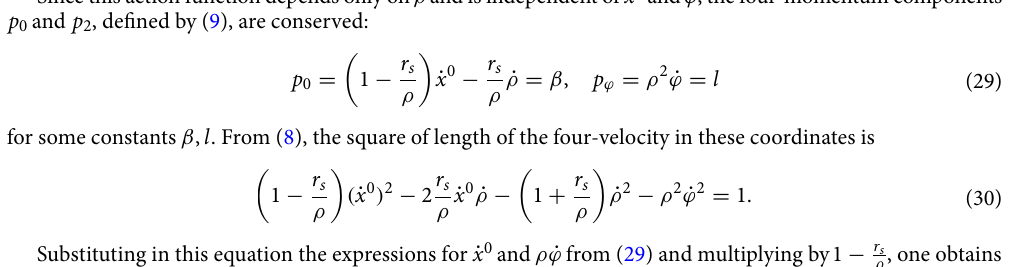
with φ( x ) defined by (26). It is well known 3 that the gravitational potential �( x ) is determined by the Poisson equation and depends linearly on the sources of the field. Consider the gravitational field outside of a static, spherically symmetric, non-rotating body of mass M . Place the origin of the spatial axes at the center of the body. For an object positioned at rest at a space point x , the rela- tive position is r = ( x , x ) and r · w = x . The classical potential �( x ) = − GM x , implying that φ( x ) = 2 GM where r s = 2 GM is the Schwarzschild radius. Thus, (27) can be written as c 2